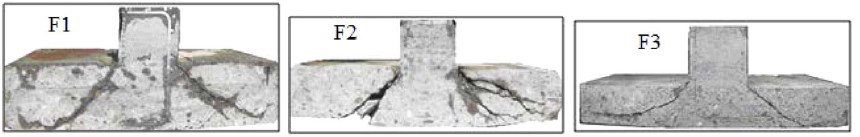
Fig. 11 Saw-cut of the failed footings.